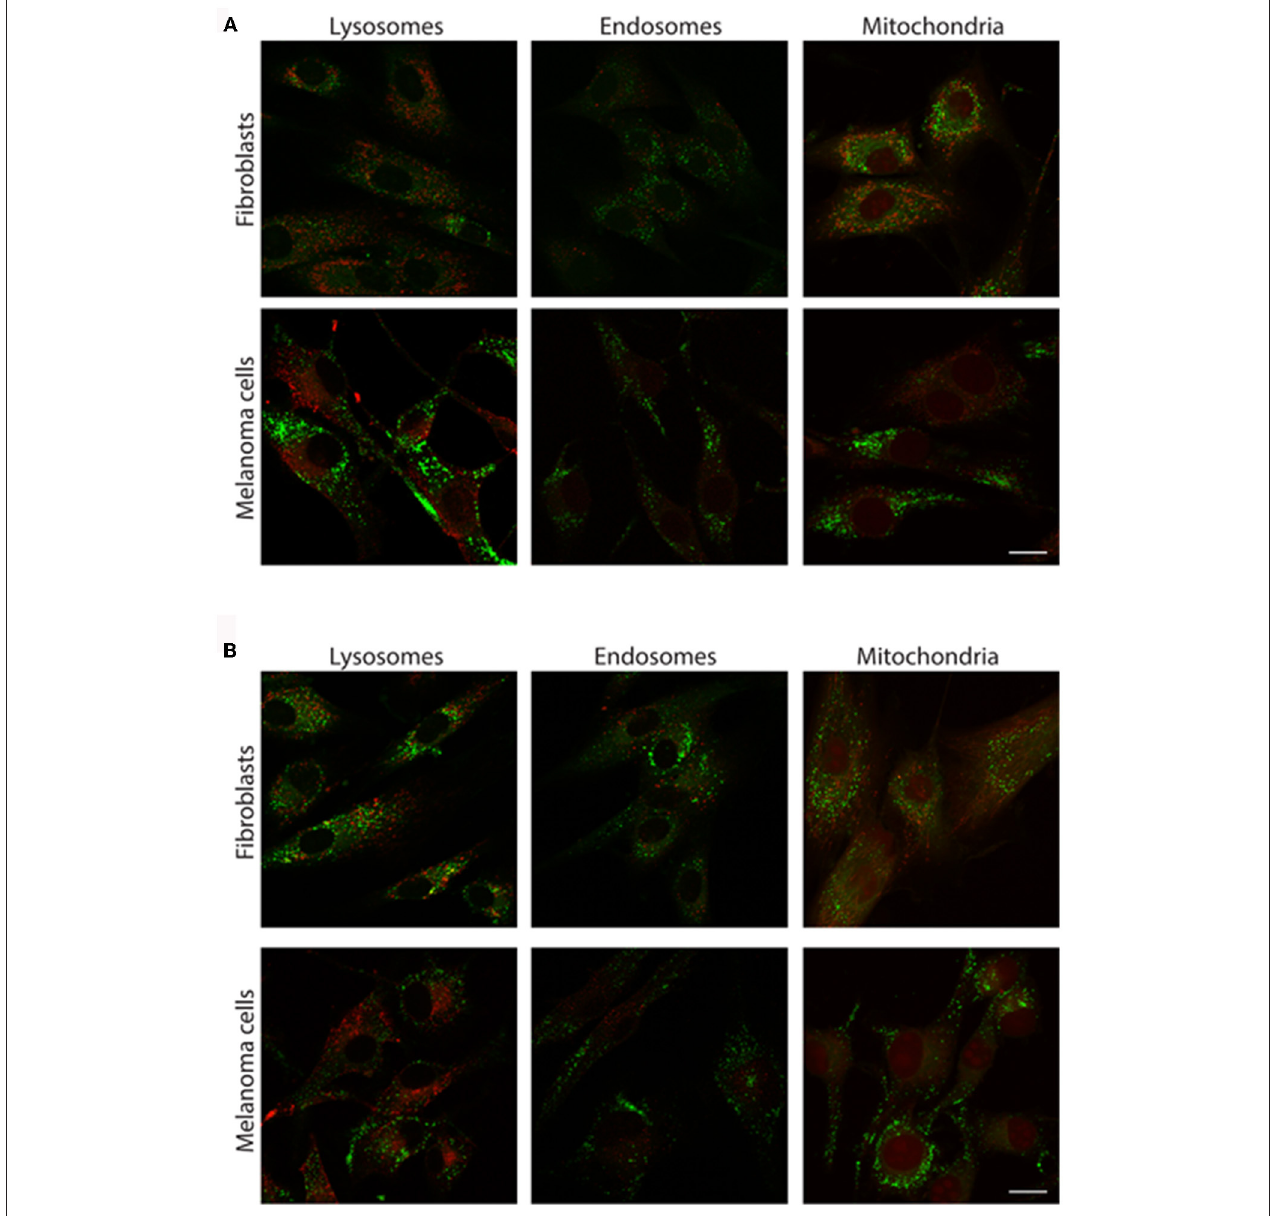
FIGURE 5 | Costaining of cells with the thienyl-phospholes and markers for intracellular compartments. Fluorescence images of human fibroblasts (AG01518) and malignant melanoma cells (SK-MEL-28) stained with phospholes 2a (A) and 3a (B) , seen in green. The cells were co-stained with markers for lysosomes (LAMP-2), early endosomes (EEA-1), and mitochondria (Mitotracker), seen in red. Scalebars = 10 µ